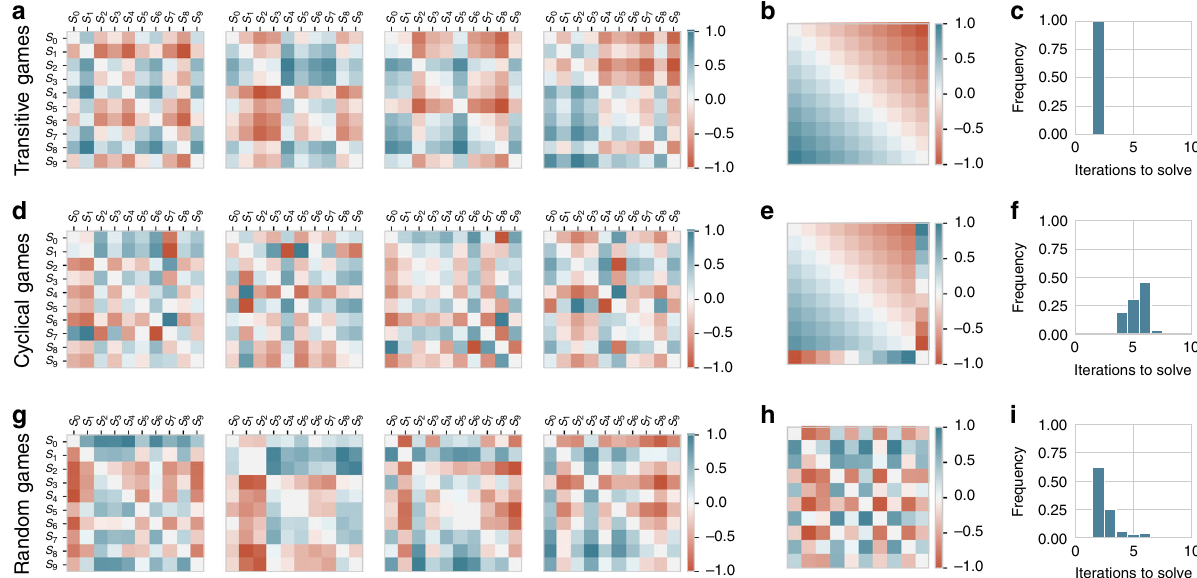
Fig. 2 Motivating example of three classes of two-player, symmetric zero-sum games. a , d , and g , respectively, visualize payoffs for instances of games with transitive, cyclical, and random structure. Each exempli fi ed game consists of two players with 10 strategies each (with payoff row and column labels, { s 0 , … , s 9 }, indicating the strategies). Despite the numerous payoff variations possible in each class of games illustrated, each shares the underlying payoff structure shown, respectively, in b , e , and h . Moreover, variations in payoffs can notably impact the dif fi culty of solving (i.e., fi nding the Nash equilibrium) of these games, as visualized in c , f , i